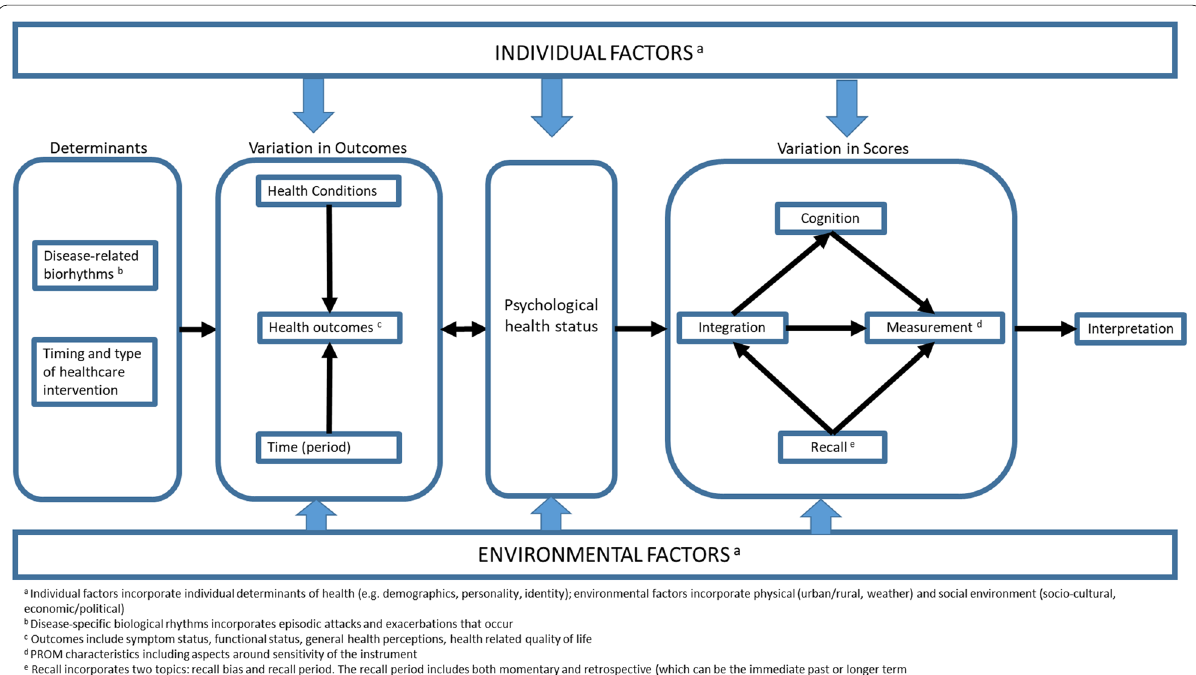
Fig. 3 Conceptual model for cyclical variation of Patient Reported Outcome Measures